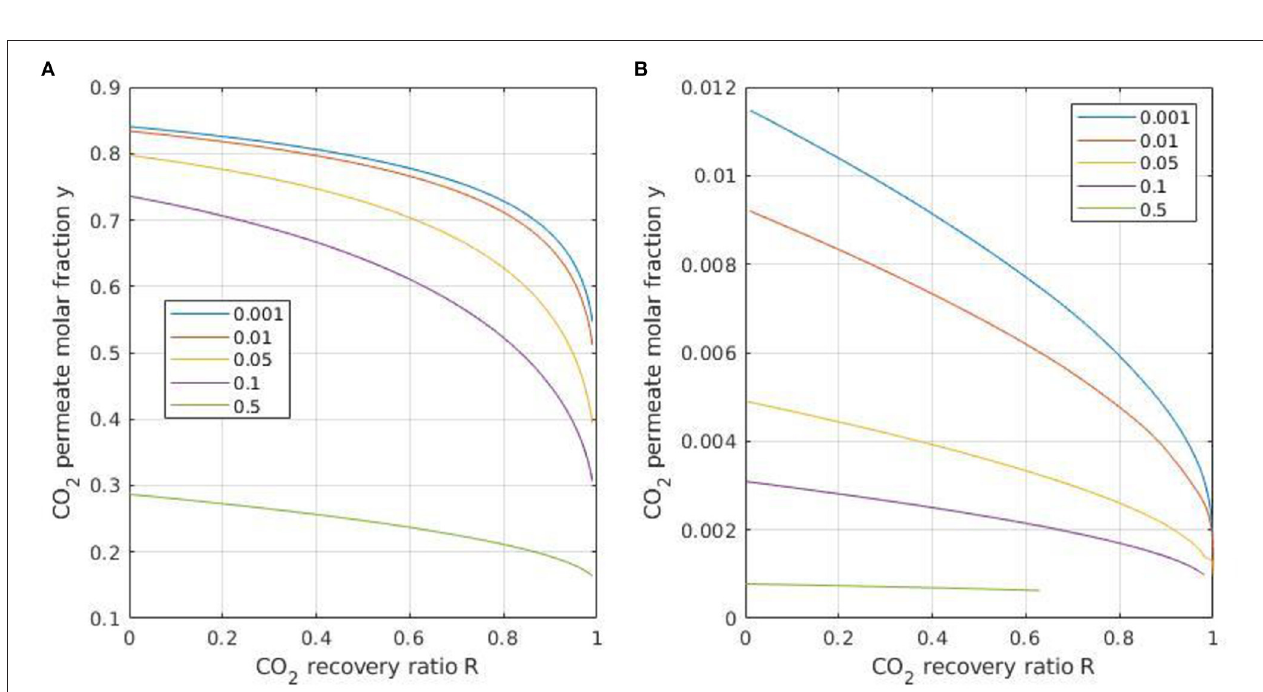
FIGURE 4 | Simplified representation of the engineering methodology which is applied in this study. Q stands for air or flue gas feed flowrate, x IN for inlet mole fraction, p ′′ for permeate pressure, p ′ for retentate pressure. ψ is the module pressure ratio, θ the module stage cut, and S the dimensionless surface area. For DAC, the objective is to get for each set of operating conditions the CO 2 outlet (permeate) concentration y, the CO 2 recovery ratio R, and the associated energy requirement E and membrane productivity π .